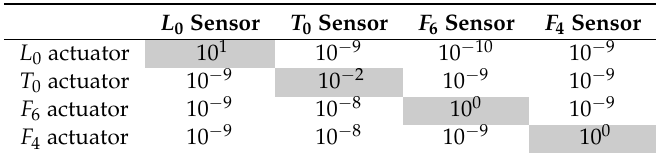
Figure 22. Third verification model. The left and right ends extend five wavelengths to prevent interference from reflected waves. The L 0 , T 0 , F 6 , and F 4 transducers are successively used as actuators and sensors. Table 3. Magnitudes of voltage responses without damage. The diagonal elements in grey color have several magnitudes higher than the non-diagonal